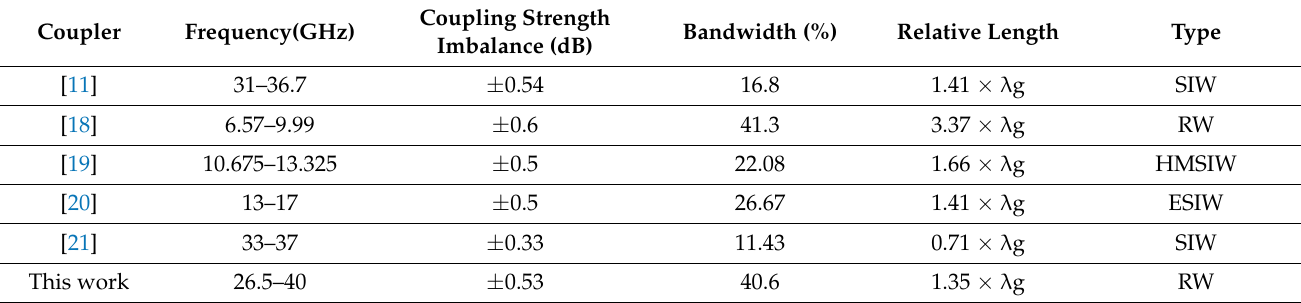
Table 1. Performance comparison of some recently reported 3 dB directional